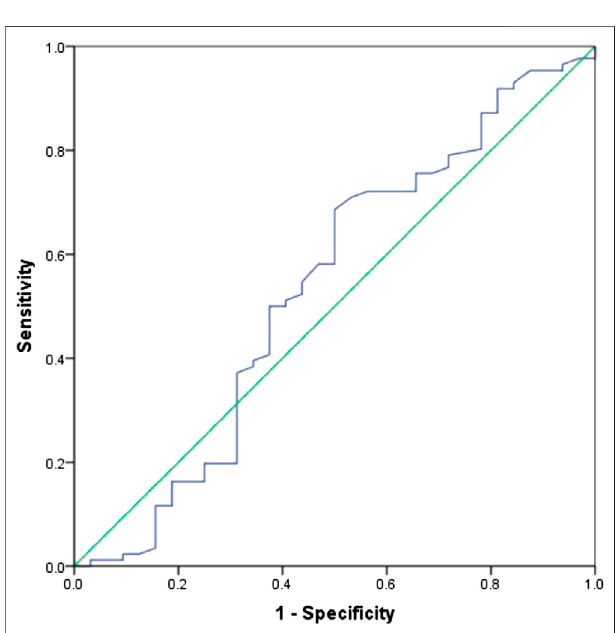
FIGURE2| ROCcurveofSUV max ofprimarytumorsin118patients with